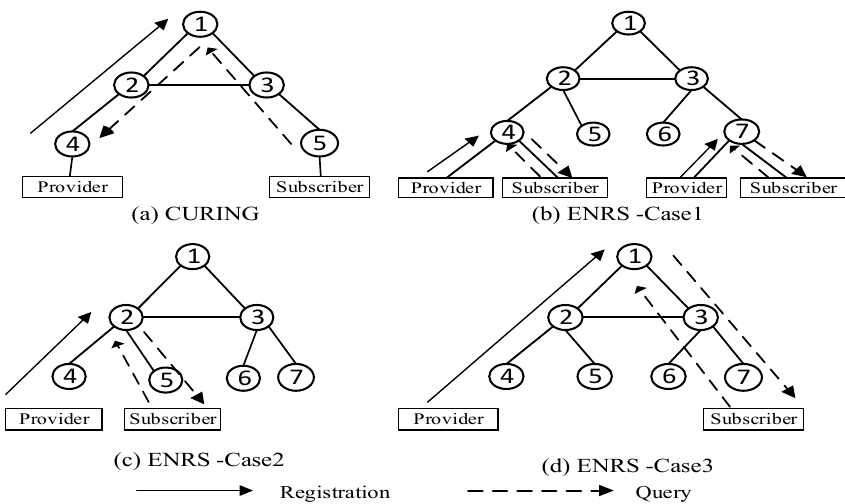
Figure 3. The examples of name resolution processes. ( a ) shows the name registration and query message forwarding processes of CURING. ( b – d ) shows the message forwarding processes of three situations of name registration and query in ENRS